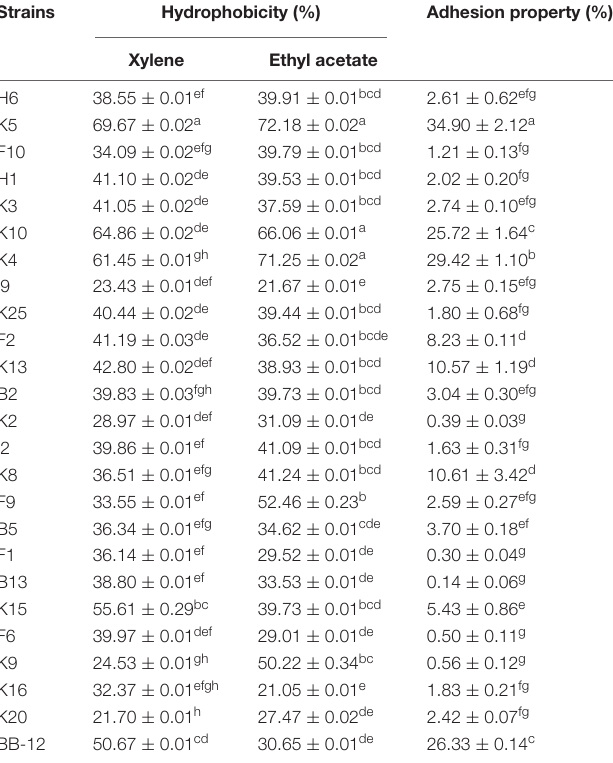
TABLE 2 | Adhesion properties of B. longum subsp. longum strains: Cell surface hydrophobicity of in xylene solution and ethyl acetate solution, and adhesion property of B. longum subsp. longum strains to HT-29